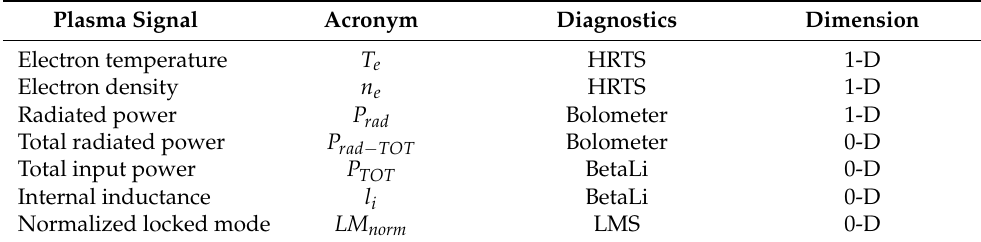
Table 1. Diagnostic signals, acronyms, and units. Plasma